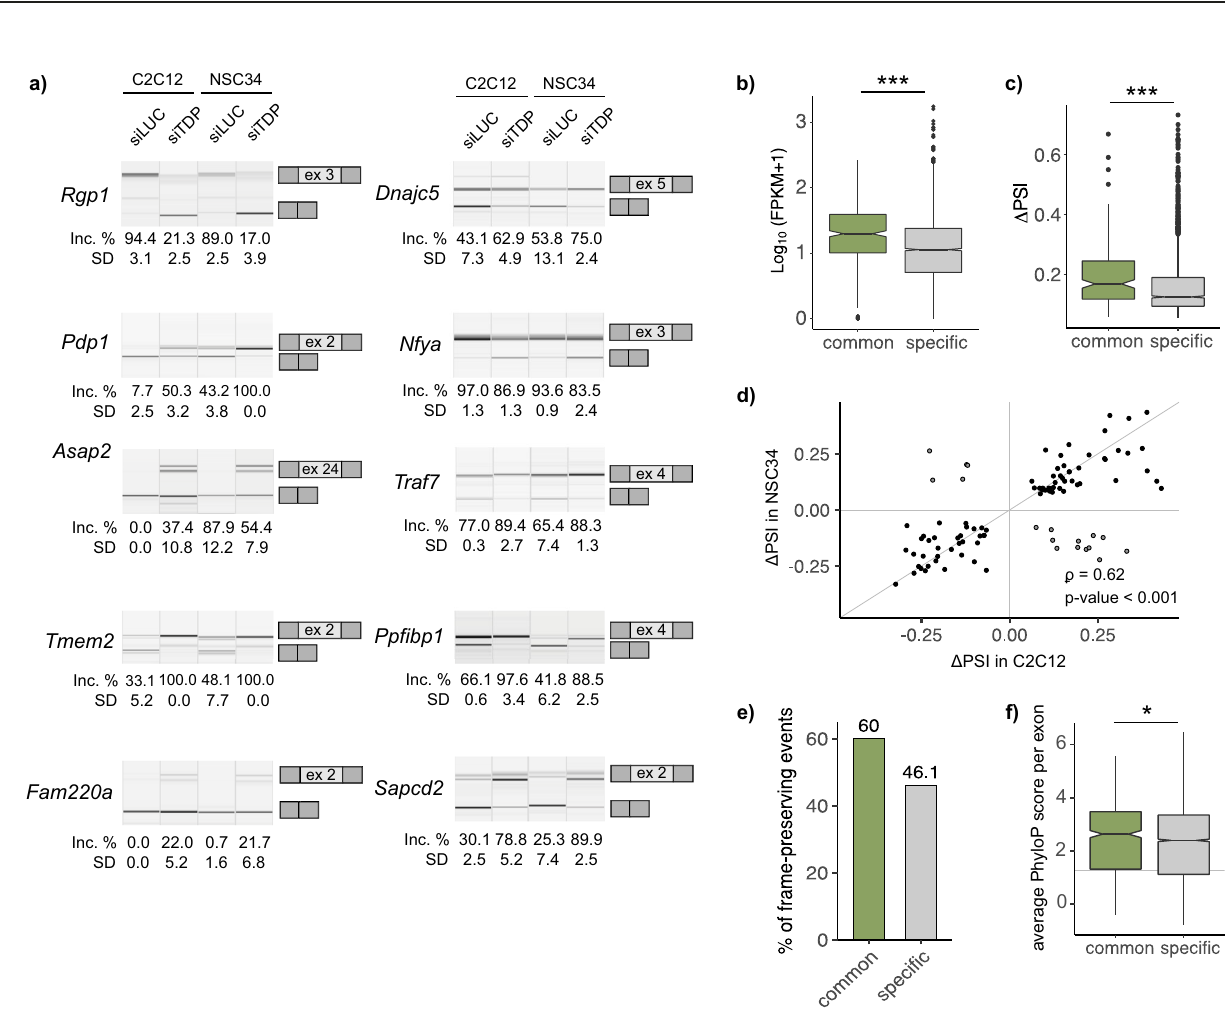
Fig. 6 Cell-type-characteristic RBPs in fl uence splicing of TDP-43 targets. a Expression levels of four RBPs following their knock-down in C2C12 and NSC34 cells ( Celf2 and Khdrbs3 were silenced in C2C12; Elavl3 and Elavl4 were silenced in NSC34) as assessed using qPCR. p -values were generated using Student ’ s t -test (paired, two-tailed, n = 3 per group). b C2C12-speci fi c and c NSC34-speci fi c TDP-43-regulated splicing. Semi-quantitative RT-PCR conducted in TDP-43-silenced samples and corresponding controls is shown along with the quanti fi cation of splicing changes (% of alternative exon inclusion). The number of the alternative exon is shown in the scheme (see the exact transcript numbers in Supplementary Table 1). Coverage track from Interactive genome viewer (IGV) is shown on the right. d Splicing of C2C12-speci fi c and e NSC34-speci fi c TDP-43 targets depends on the presence of other tissue-speci fi c factors. RT-PCR was conducted in samples silenced for speci fi c RBPs ( Celf2 and Khdrbs3 in C2C12; and Elavl3 and Elavl4 in NSC34 cells) together with corresponding controls. Quanti fi cation of splicing changes is shown below (% of alternative exon inclusion). Signi fi cance was tested using Student ’ s t -test (paired, two-tailed, n = 3 per group).